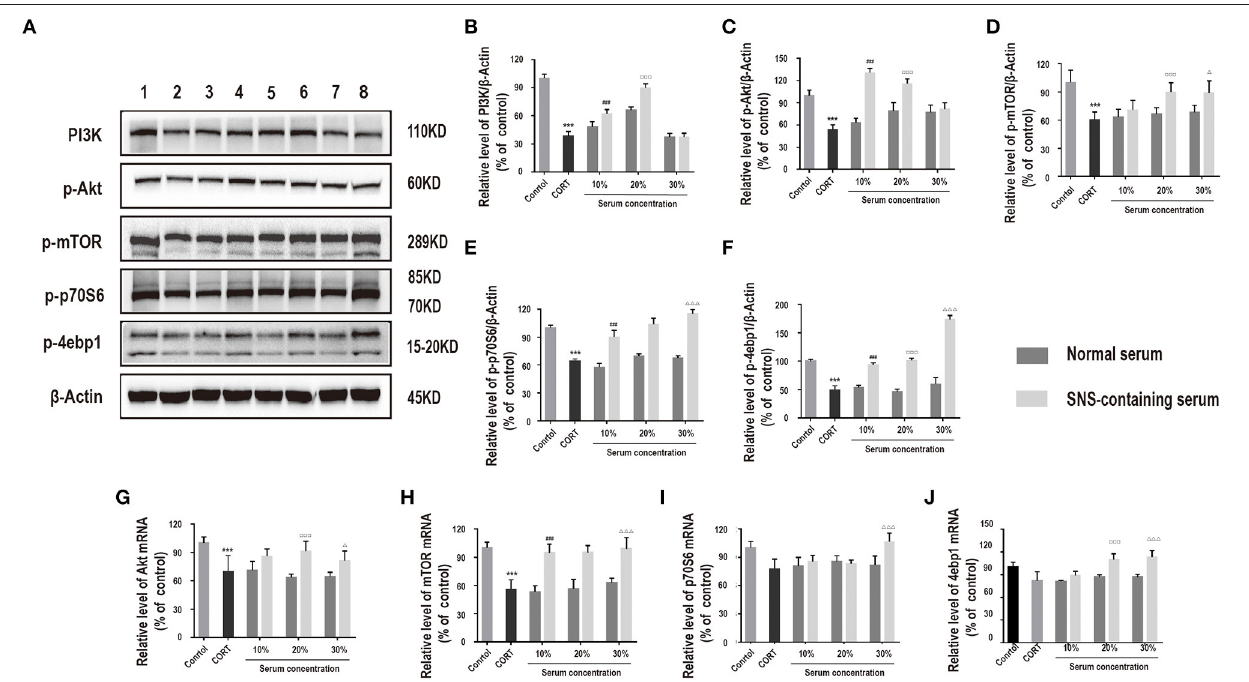
FIGURE 5 | Cells were incubated with 200 µ M corticosterone and SNS-containing serum for 24h. (A–F) Western blot and quantitative analyses of PI3K, p-Akt, p-mTOR, p-p70S6, and p-4ebp1 protein, ( n = 3). (G–J) qRT-PCR analysis of Akt, mTOR, p70S6, and 4ebp1 expression levels. *** P < 0.01 vs. control group; ### P < 0.01 vs. 10% normal serum group; (cid:3)(cid:3)(cid:3) P < 0.01 vs. 20% normal serum group; 1 P < 0.05, 111 P < 0.01 vs. 30% normal serum group ( n =